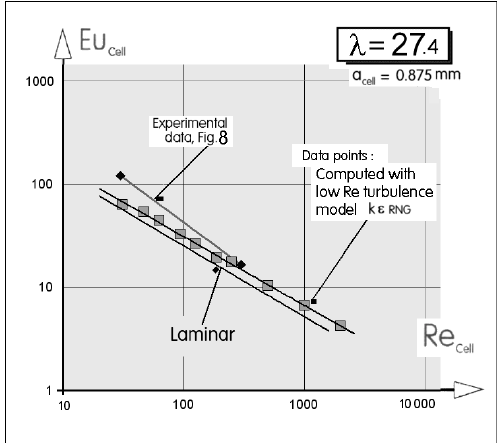
Figure 14. Computation results obtained with the turbulence model modified for very low turbulence Reynolds numbers—under the same conditions as Figure 13.